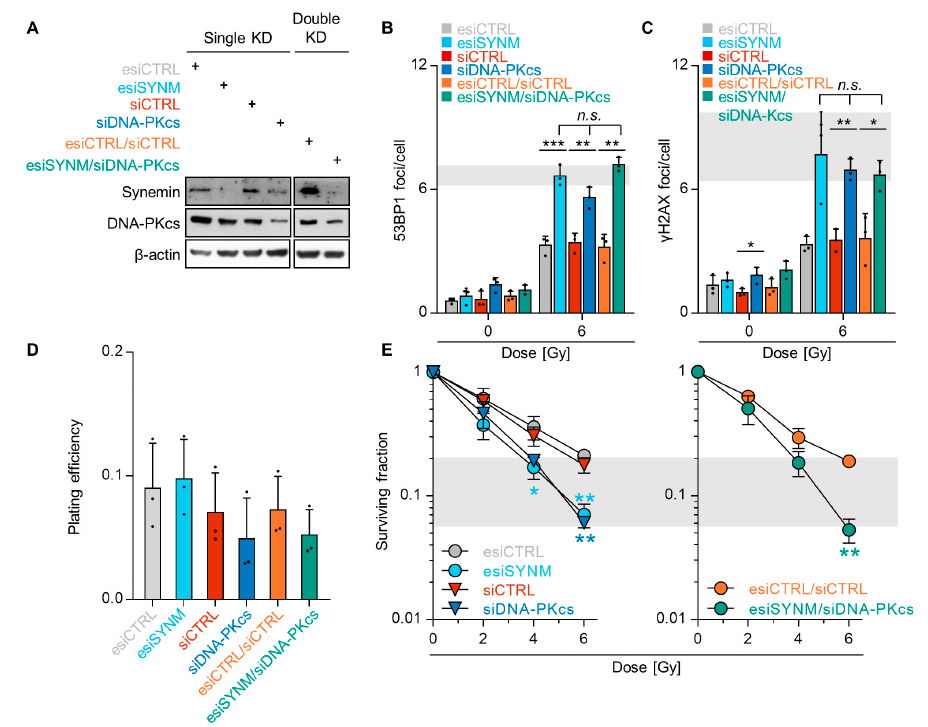
Figure 4. Synemin/DNA-PKcs co-control DSB repair and radiation survival. ( A ) Knockdown efficiencies of single and double esi/siRNA transfections of SAS cells. β -actin served as loading control; ( B , C ) Residual 53BP1 and γ H2AX foci per cell (24 h after irradiation) upon single and double knockdown of synemin and DNA-PKcs in 6-Gy X-ray irradiated SAS cells. Transfection with single or double non-specific siRNA were used as controls; ( D ) Plating efficiency of SAS cells upon single and double knockdown of synemin and DNA-PKcs; ( E ) 3D colony formation ability upon single and double silencing of synemin and DNA-PKcs. Data are represented as mean ± SD ( n = 3; two-sided t -test; * p < 0.05, ** p < 0.01, *** p < 0.001; n.s., not significant ( p ≥